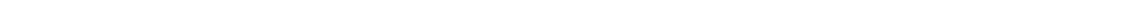
Fig. 4 Populations analysis. a Maximum likelihood phylogenetic tree based on 3,933,264 SNPs for 53 B. distachyon lines. Thickness of branches indicates bootstrap support (thick, 100%; intermediate, 70 – 99%; thin, 50 – 69%). Insets at select nodes (N) show the probabilities for the ancestral state of the traits in c and e . b Plot of individual membership (SNP pro fi les) to optimal K = 3 Bayesian STRUCTURE groups: EDF+ (blue), T+ (yellow), S+ (green) (see Supplementary Table 3). c – e Color-coded matrix based on mapping all trait values to discrete state categories for fl owering phenotypes ( c ), collection site latitude ( d ), and DNA variants in known fl owering genes ( e ). Color labels can be found in Supplementary Table 4. f Geographic distribution of accessions. Points labeled as: Extremely Delayed Flowering (EDF+): square; Delayed Flowering (DF): circle; Intermediate Delayed Flowering (IDF): triangle; Intermediate Rapid Flowering (IRF): open triangle; Rapid Flowering (RF) and Extremely Rapid Flowering (ERF): star. Colors re fl ect membership to STRUCTURE groups in b . The background map was constructed from Worldclim (http://www.worldclim.org/) elevation date using ArcGIS software